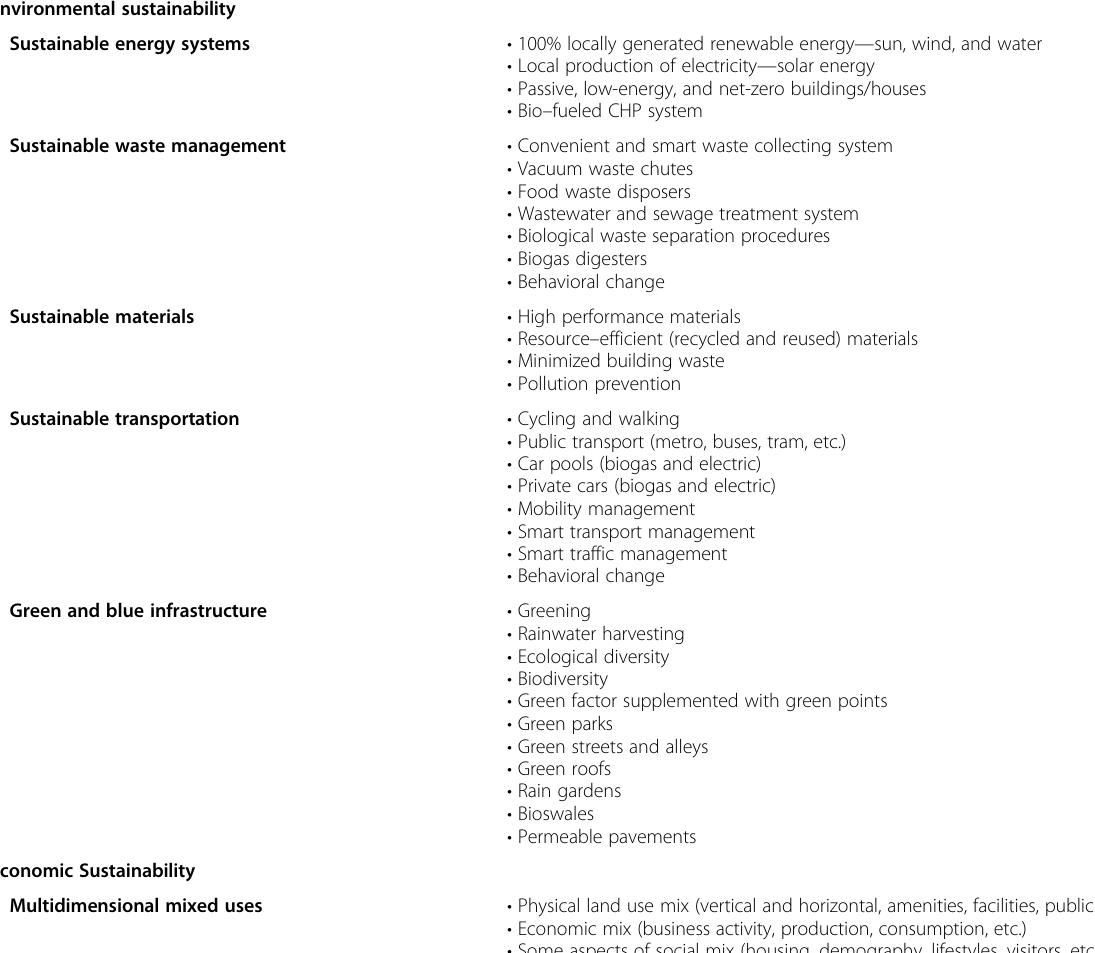
Table 3 The key strategies and solutions of the eco-city district for achieving the three goals of sustainability Design and technology